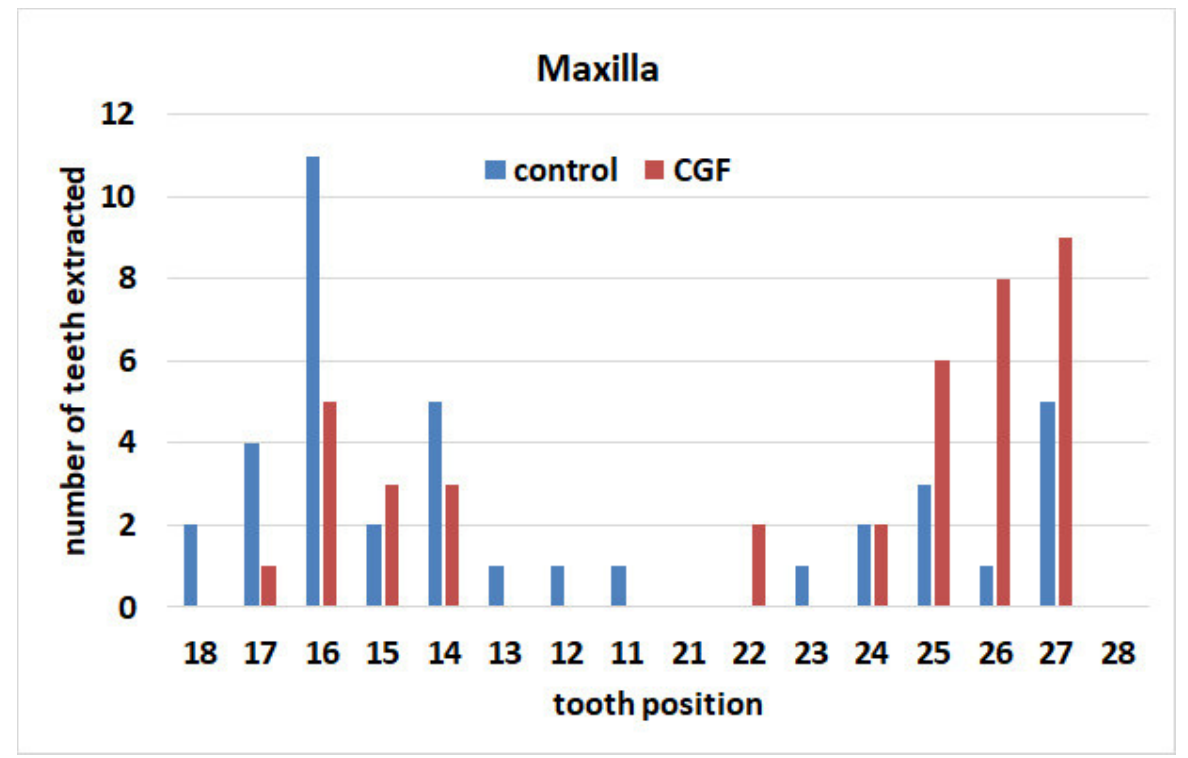
Figure 1. Distribution of extracted teeth according to location in the two groups. ( A ) Maxilla; ( B ) mandible.